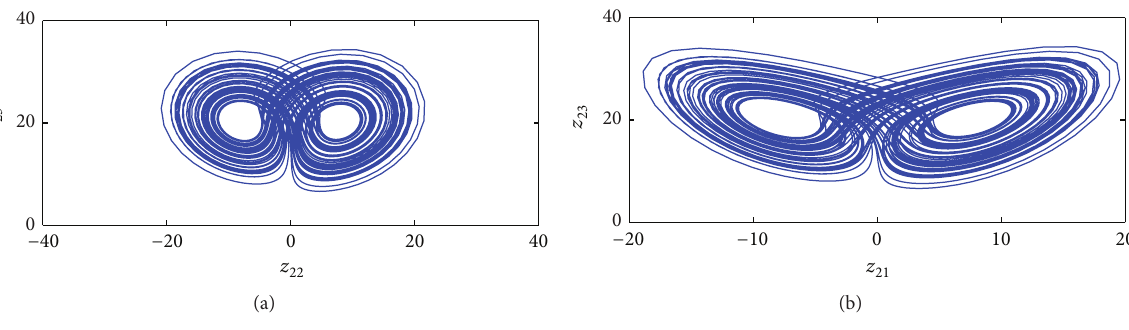
Figure 3: The chaotic attractor of system (21) for 𝑞 𝑑2 = 0.96 .